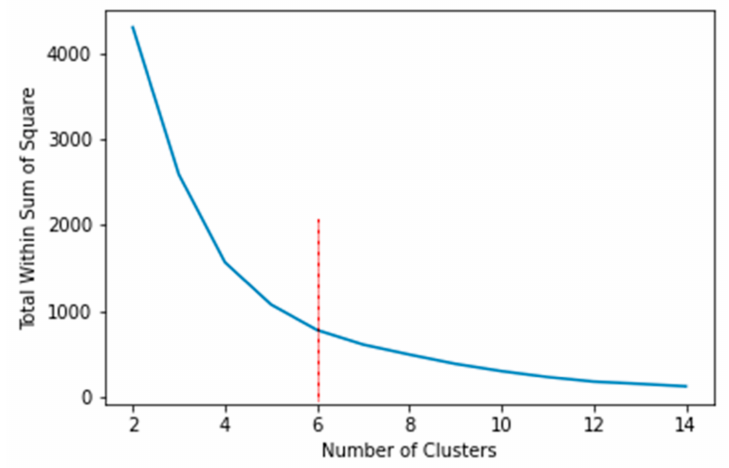
Figure 3. Curve of elbow method generated for the database with all age groups. The number of the cluster was determined by looking at the point position on the “elbow”